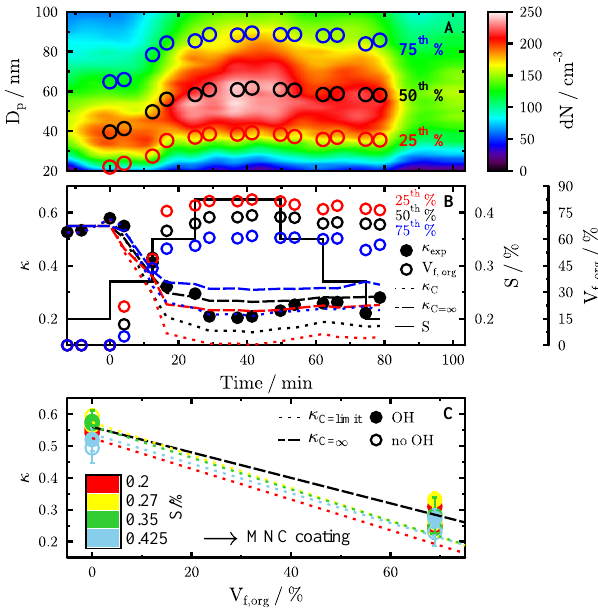
Figure 9. CCN activity of MNC-coated KS particles before and after exposure to OH. Panel (a) shows a color map of the number- weighted particle size distribution ( dN ) of KS and MNC-coated KS particles plotted as a function of MNC coating before exposure to OH. The open circles in panel (a) refer to the measured percentiles of the total particle population (25th: red; 50th: black; 75th: blue). Panel (b) displays the change in particle hygroscopicity (filled cir- cles) and MNC volume fraction ( V f,org , open circles) with time as a function of S given as a black solid line corresponding to the data presented in panel (a) . The dotted lines show the predicted κ using the volume mixing rule corresponding to the V f,org at a given time and based on the experimentally derived κ for KS and MNC given in Table 1 as a function of S . The dashed lines represent the predicted κ using the volume mixing rule corresponding to the V f,org at a given time and assuming the CCN activity of MNC is not limited by its solubility (i.e., MNC κ = 0 . 16 calculated from Eq. 6). Panel (c) dis- plays the change in κ for the MNC-coated KS particles as a function of V f,org , OH exposure, and S . OH unexposed particles are plotted as open circles. Filled circles correspond to particles exposed to OH at 3.3 × 10 11 moleculecm − 3 s. The error bars represent 1 σ from the mean in κ . The colored dotted lines show predicted κ as a function of V f,org at different S using the volume mixing rule assuming the CCN activity of MNC is limited by its solubility. The black dashed line shows the predicted κ using the volume mixing rule assuming the CCN activity of MNC is not limited by its